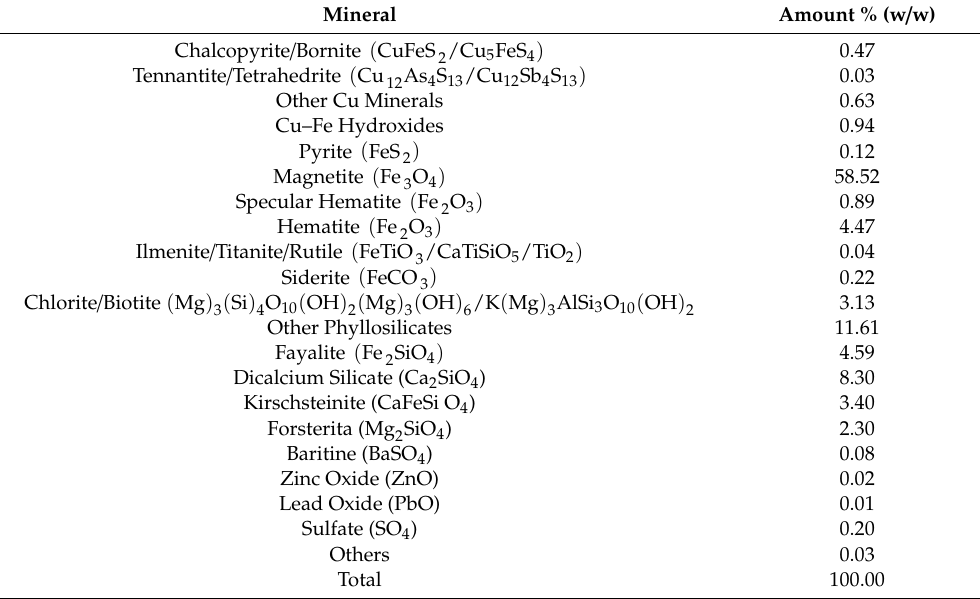
Table 2. Mineralogical composition of tailings, as determined by